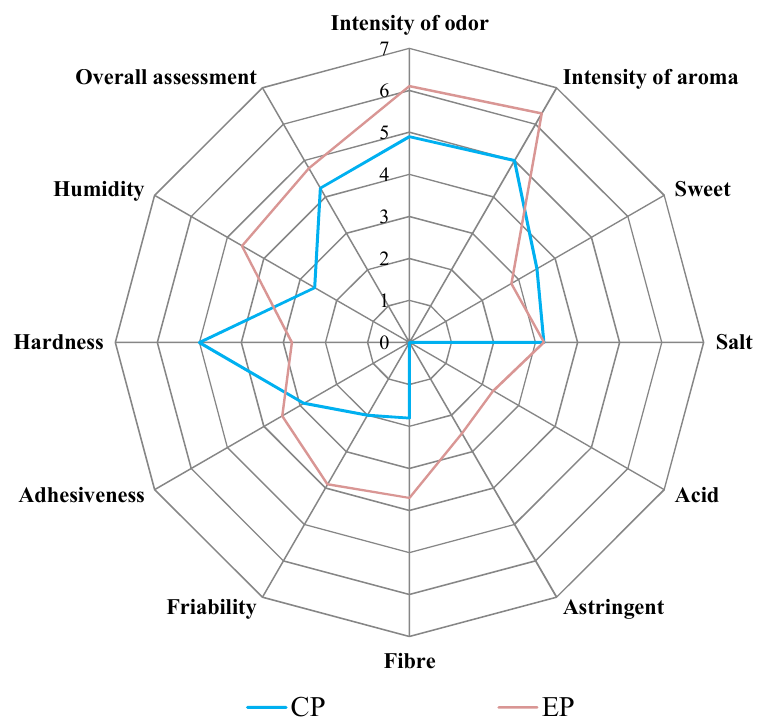
Figure 5. Spider diagrams corresponding to the descriptive sensory analysis of cheeses. Abbreviations: CP, control production inoculated with a commercial starter culture; EP, experimental production inoculated with a commercial starter culture +1% of GPP.